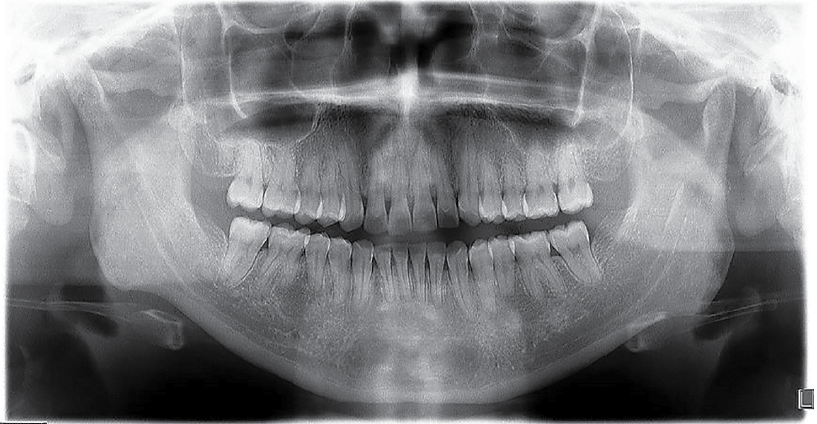
Figure 9- Case 4. A mixed, intraosseous, well-defined image from right mandibular canine to its contralateral counterpart is seen. A mixed, well-defined lesion is seen in the mandibular right premolar-molar zone. This image is the cicatrization area corresponding to a lesion previously diagnosed as an odontogenic